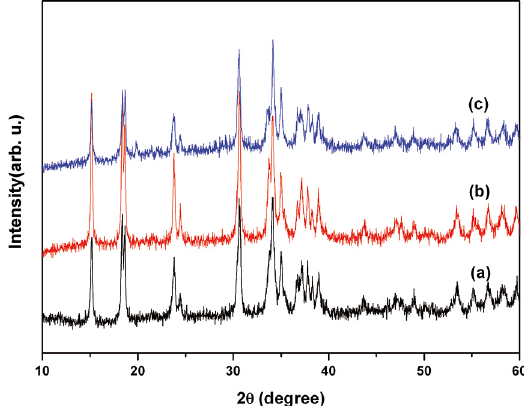
(OH)PO prepared from Figure 1: X-ray diffraction patterns of Cu 2 4 three different types of cupric salts as raw materials (a) Cu(NO ) •3H O; 3 2 2 (b) CuSO •5H O; (c) Cu(CH COO) •H O 4 2 3 2 2 pure orthorhombic phase as all diffraction peaks of these samples are well matched with JCPDS card number 36- 0404. The ration difference between diffraction peaks of different samples may be induced by the different exposed crystal faces. The amount of different exposed crystal faces can induce the difference of intensity of diffraction peak. No diffraction peaks for other phases or materials (such as pseudomalachite [Cu (OH) (PO ) ]) or copper phosphate 5 4 4 2 hydrate [Cu (PO ) •3H O] are observed in XRD patterns, 3 4 2 2 indicating a high purity and crystallinity of the final